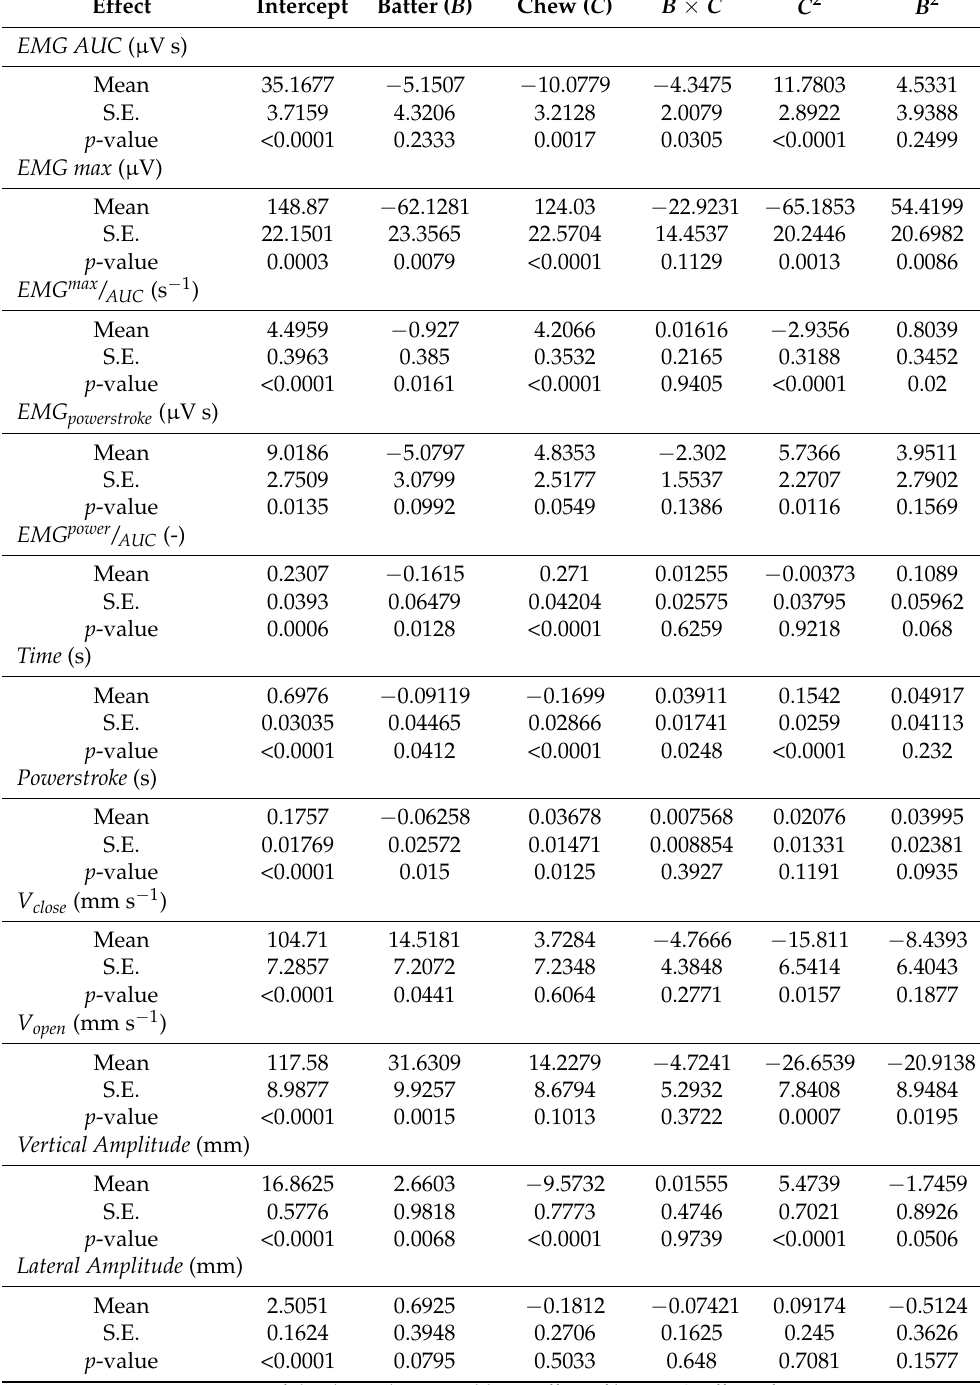
Table 3. Model terms of the oral processing parameters fit in SAS (Equation (1)) for the samples with 0–100% BLS. The intercept corresponds to the sample with 0% BLS, effects of chew and batter are given over the duration of one sequence (relative time 0–1) and amount of BLS (0–100%),